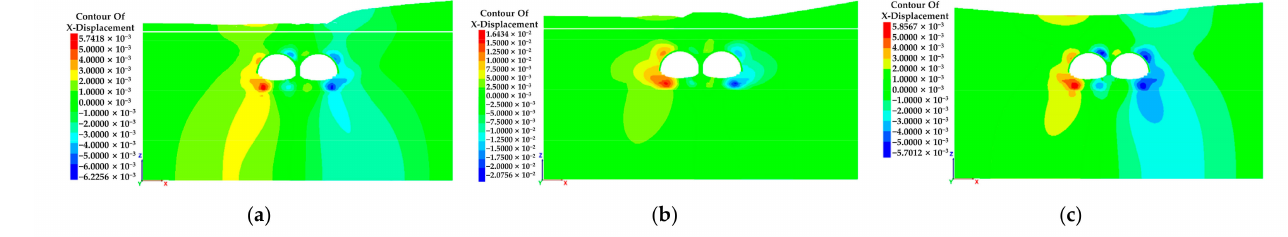
Figure 15. Horizontal deformation of surface and surrounding rock after excavation of main tunnel (unit: m): ( a ) Y = 40 m; ( b ) Y = 100 m; ( c ) Y = 130